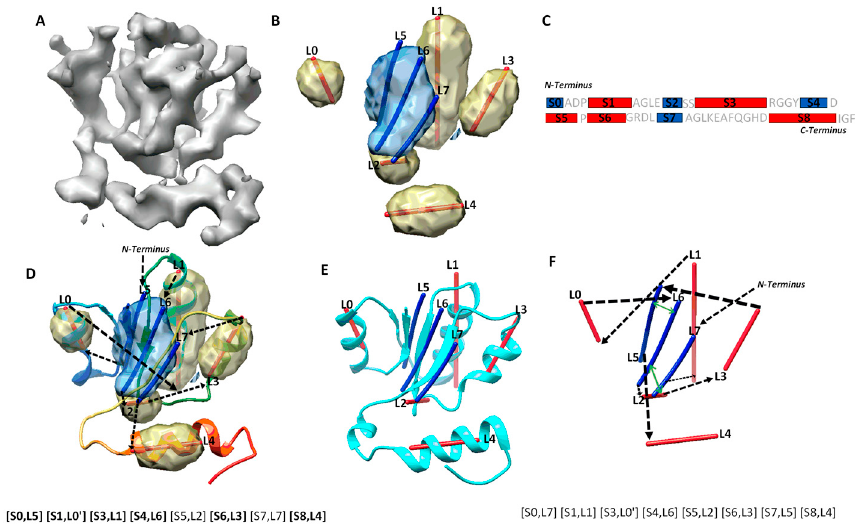
Figure 1. Secondary structure sequence segments, image traces, topology, and pair-contact. ( A ) The cryo-EM density map (gray, EMDB ID 6810) component that corresponds to chain H of atomic structure 5y5x (PDB ID). ( B ) The detected secondary structure regions of α -helices (yellow density) and β -sheet (blue density) using DeepSSETracer [20]. α -traces (red lines) were derived using Principle Component Analysis for α -helices, and β -traces (blue lines) were predicted for β -strands using StrandTwister [21]. ( C ) An illustration of the amino acid sequence of protein 5y5x chain H annotated with the locations of helices (red rectangles) and β -strands (blue rectangles) predicted using JPred [30]. ( D ) An example of a correct topology shown as a diagram and as a list of mapped pairs. Black arrows indicate the topology, with the order of the secondary structure traces from N to C terminal and direction of each trace. The atomic structure of 5y5x (PDB ID) chain H is shown as a rainbow ribbon. The correctly mapped secondary structure pairs are highlighted in the representation of the topology. ( E ) The atomic structure (cyan ribbon) of chain H in 6r0z superimposed with the secondary structure traces. ( F ) An example of a wrong topology indicated using black arrows. The secondary structure contact pairs derived from significant long-range amino acid contacts are indicated as green arrows for the wrong